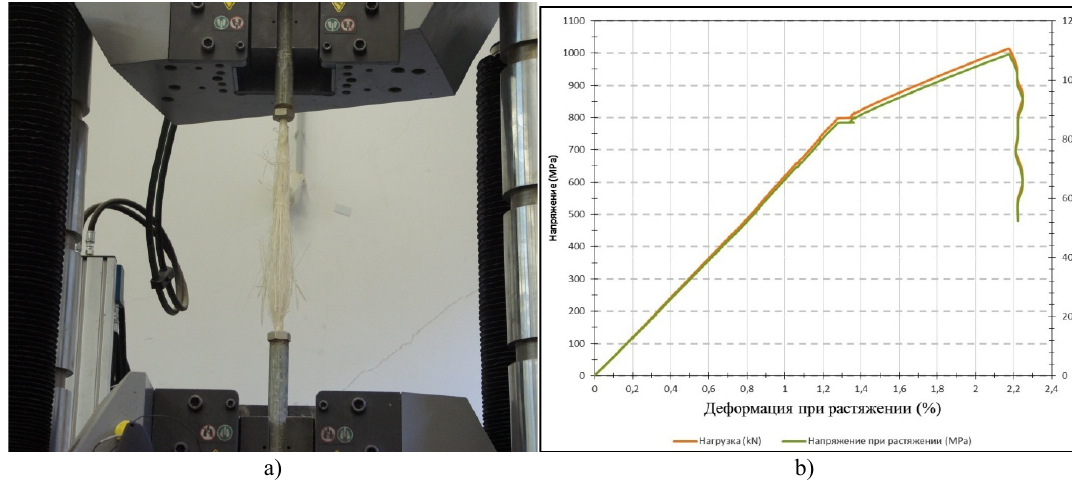
Figure 2. FRPR tests. a) The nature of FRPR destruction at the break; b) Tensile stress-strain diagram.